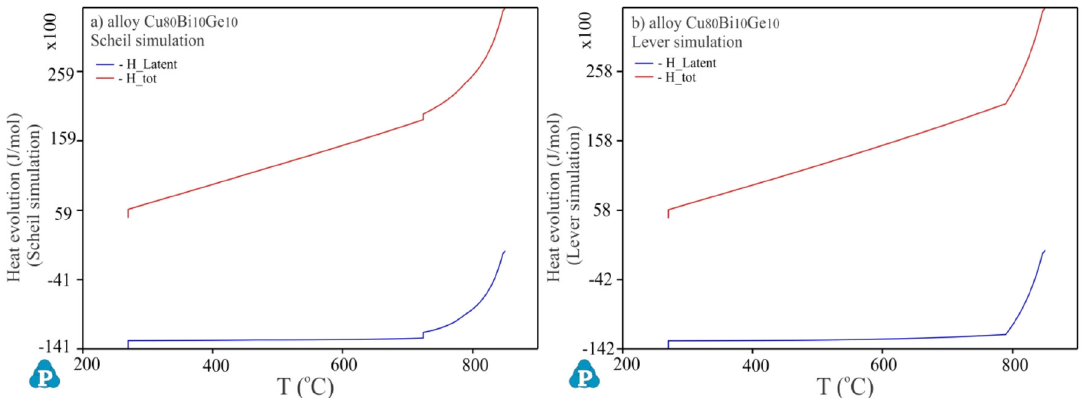
Bi Ge , a) Scheil simulation and b) Lever simulation. 80 10 10